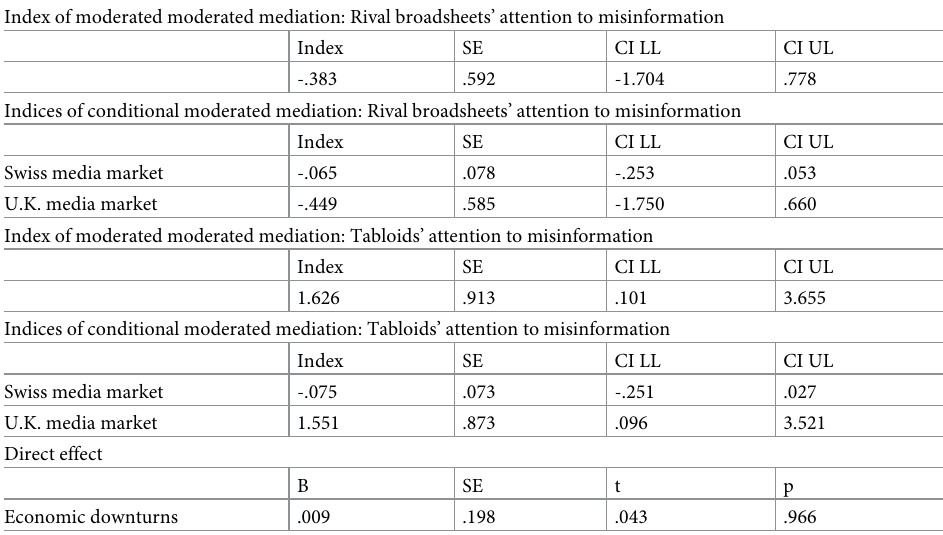
Table 8. Dual moderated parallel mediation analysis (business journalism). Index of moderated moderated mediation: Rival broadsheets’ attention to